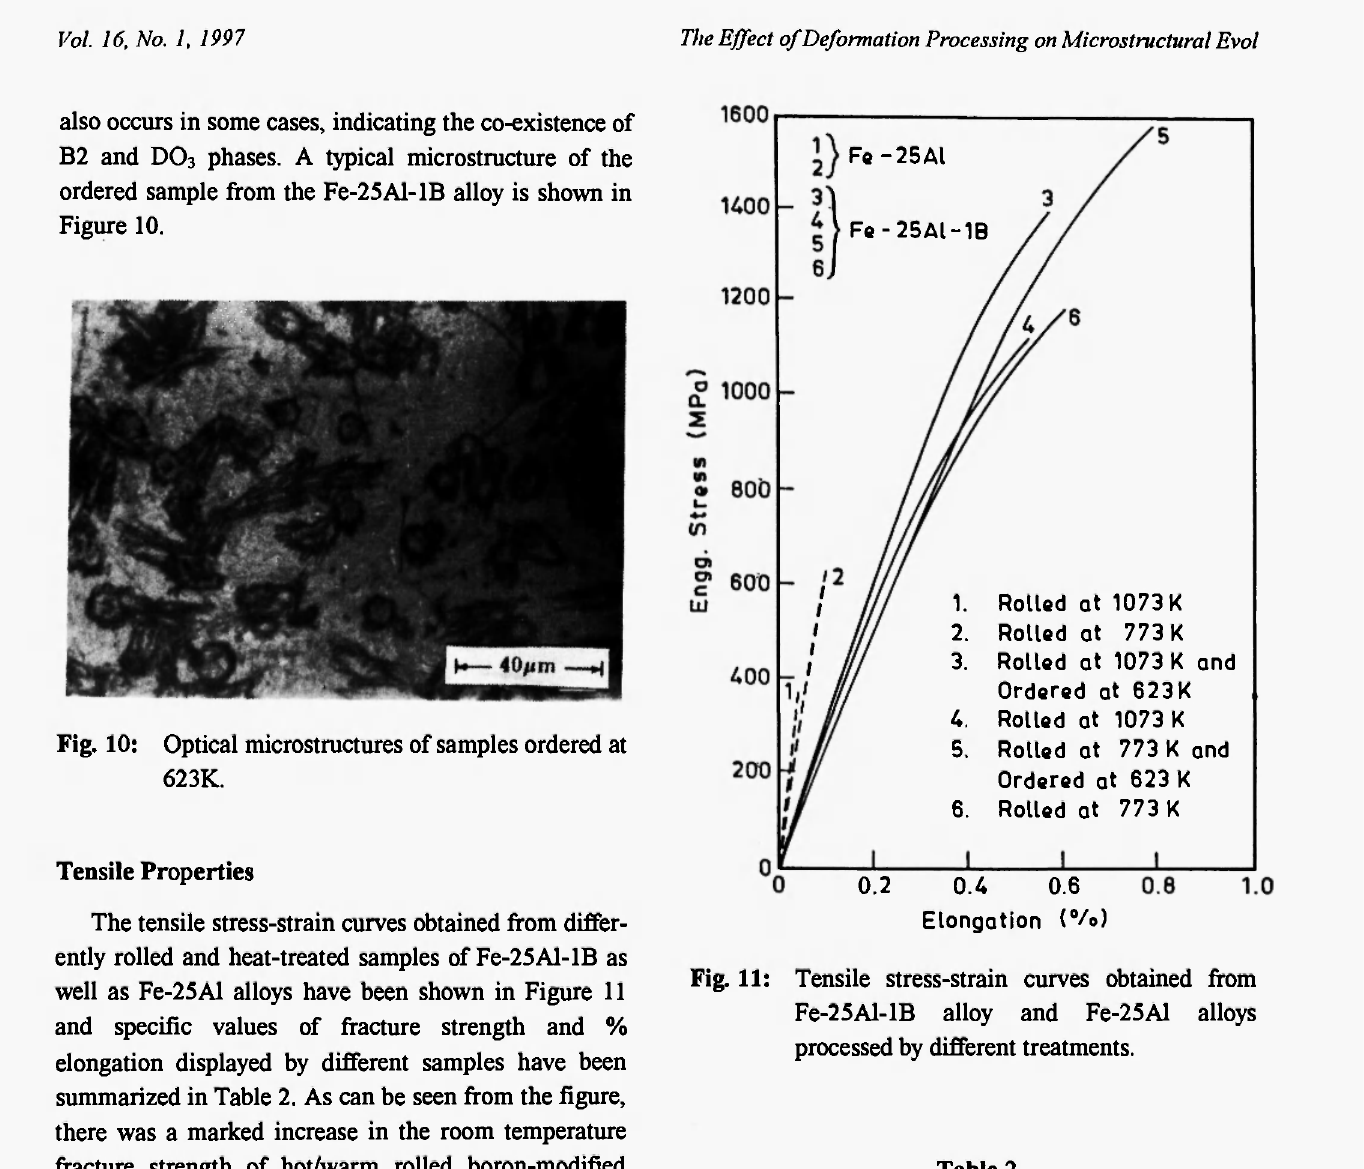
Fig. 11: Tensile stress-strain curves obtained from Fe-25A1-1B alloy and Fe-25A1 alloys processed by different treatments.